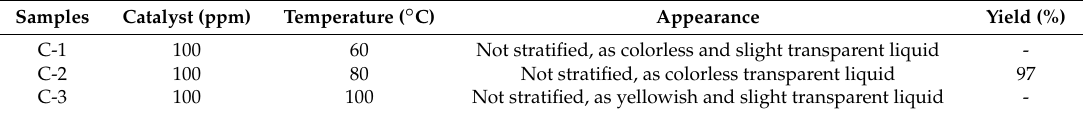
Table 5. Effect of reaction temperature on activity of catalyst.